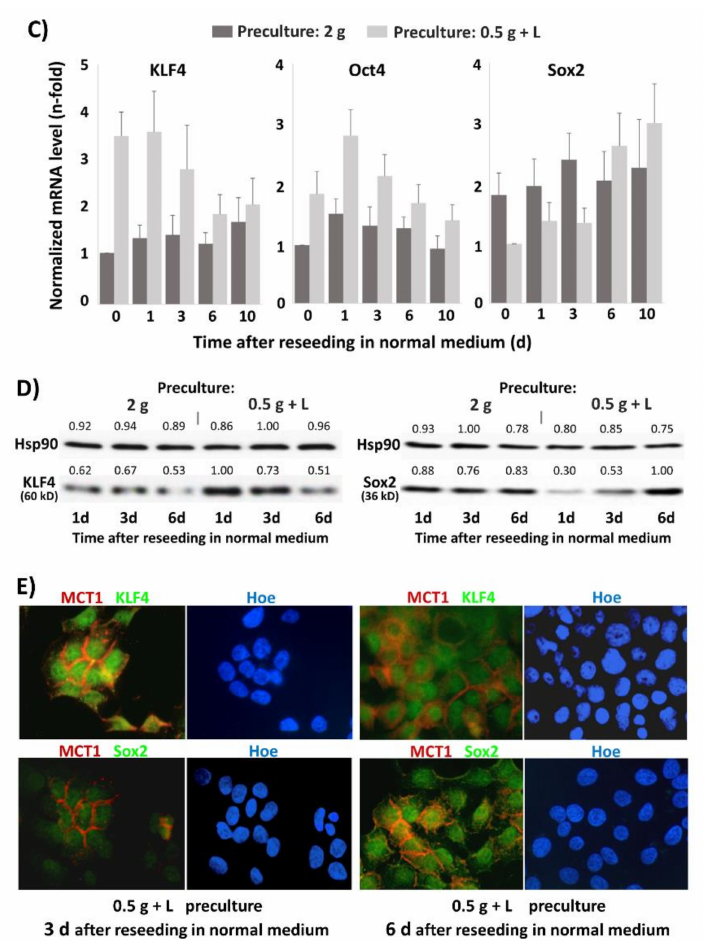
Figure 6. Lactate treatment increases stemness marker and reprogramming factor expression in T3M4 and BxPc3 cells under glucose restriction. ( A ) BxPc3 and T3M4 cells were precultured for 72 h